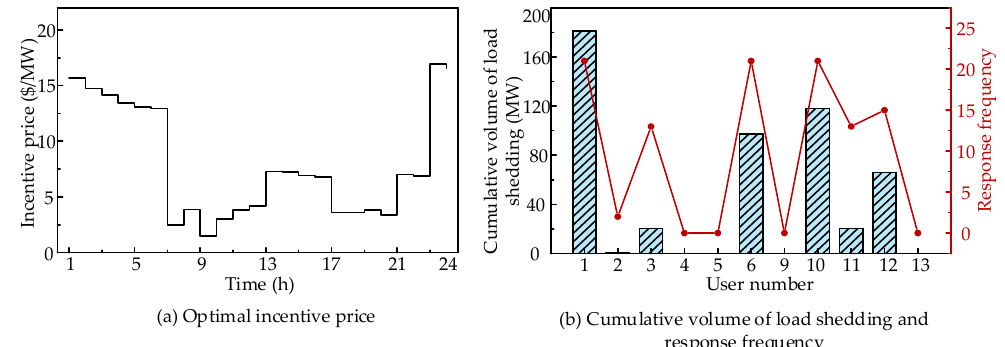
Figure 8. Equilibrium results of optimal incentive price (a) as well as cumulative volume of load shedding and response frequency (b) when the unified incentive pricing mode is adopted.